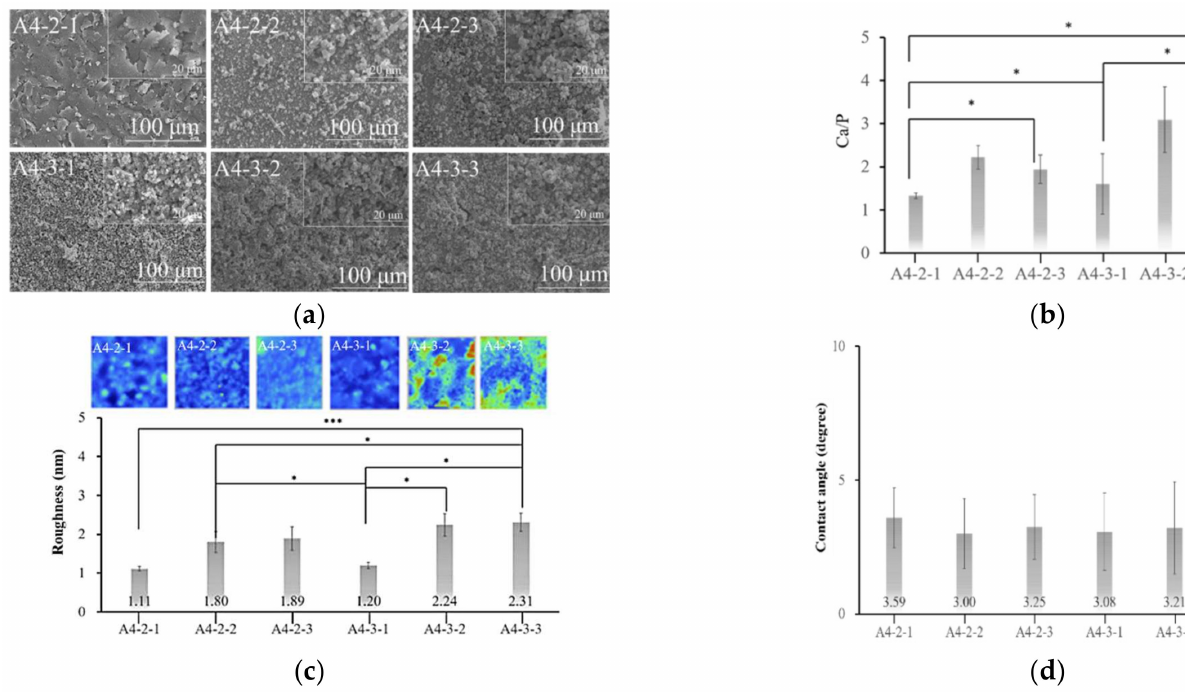
Figure 10. ( a ) The surface morphology of calcium phosphate was observed via SEM. ( b ) The calcium– phosphorus ratio (Ca/P) contained in the material’s surface can be measured separately via EDS, and the type of calcium phosphate can be inferred (* p < 0.05). ( c ) Surface roughness analysis. Comparing a different group of calcium phosphate (* p < 0.05; *** p < 0.001). ( d ) No significant difference. Comparison of the surface hydrophilicity after soaking in sodium